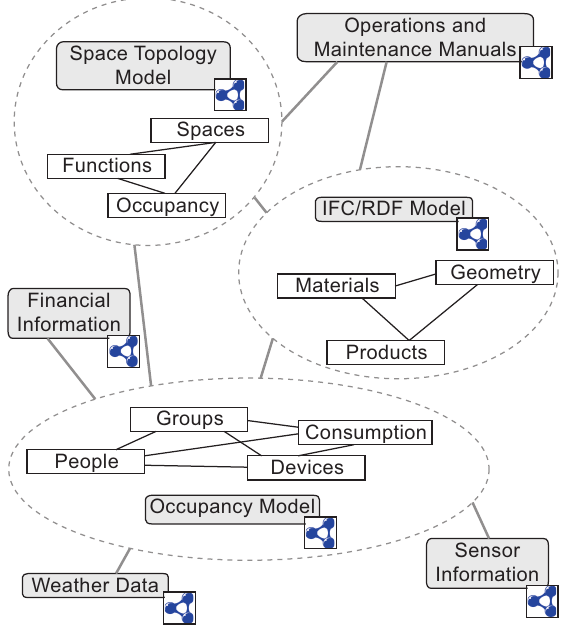
Figure 15. Extending the linked building data cloud for the AEC project with links to sensor information, operations and maintenance manuals, financial information and weather data should allow improving building performance in the maintenance phase of the building